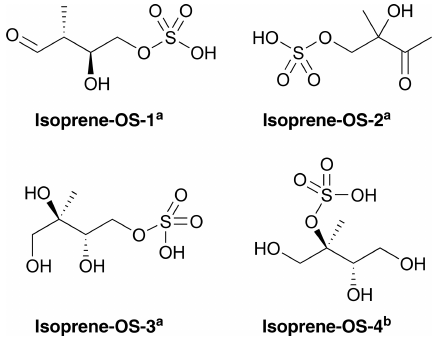
Figure 2. Structures of the studied isoprene-derived organosul- fates, provided by a Surratt et al. (2007) and b Surratt et al. (2010). Isoprene-OS-3 and isoprene-OS-4 are IEPOX-derived organosul-